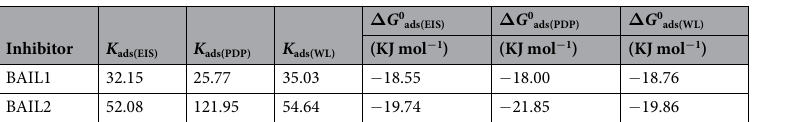
Table 4. Thermodynamic parameters for adsorption of BAIL1 and BAIL2 on the steel surface in 0.5 M HCl solution obtained from EIS, PDP and WL